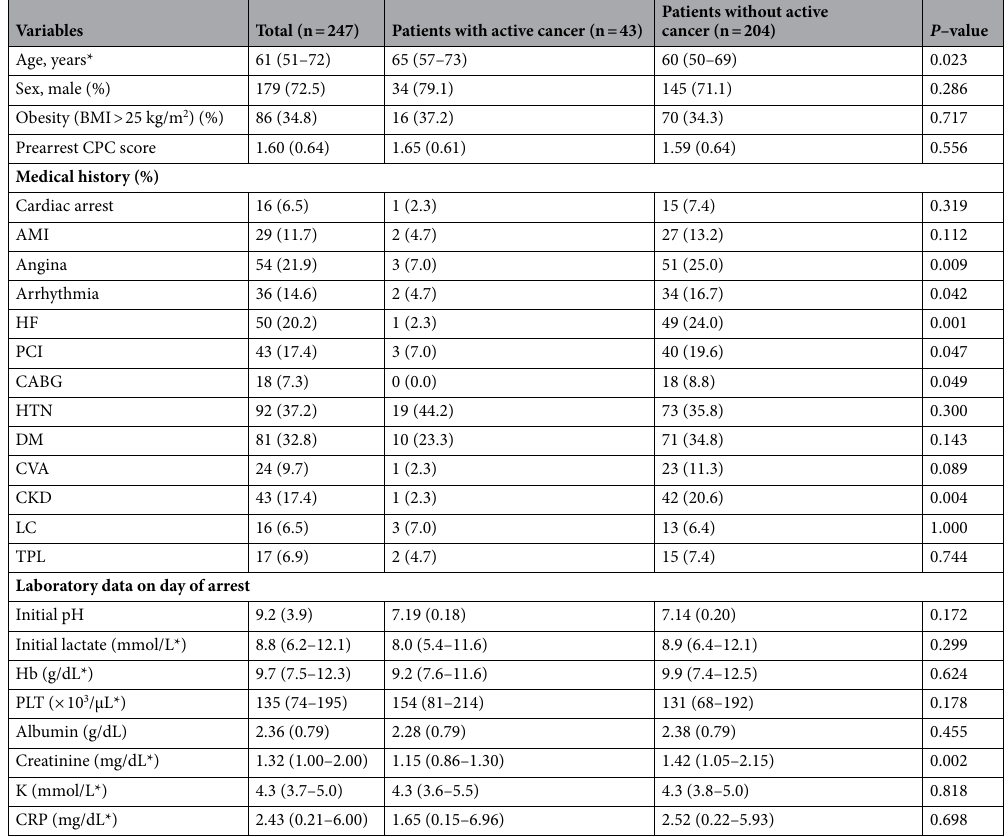
Table 1. Baseline characteristics. BMI Body mass index, CPC Cerebral performance category, AMI Acute myocardial infarction, HF Heart failure, PCI Percutaneous coronary intervention, CABG Coronary artery bypass graft, HTN Hypertension, DM Diabetes mellitus, CVA Cerebrovascular accident, CKD Chronic kidney disease, LC Liver cirrhosis, TPL Transplantation. *Median (interquartile range), otherwise mean